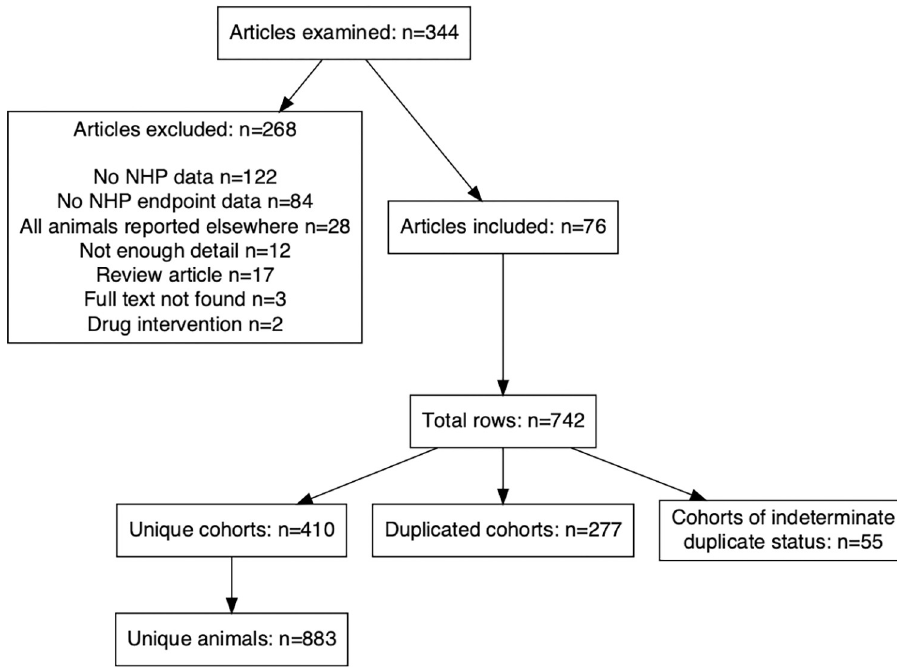
Fig 1. Schematic of the search strategy used to identify relevant